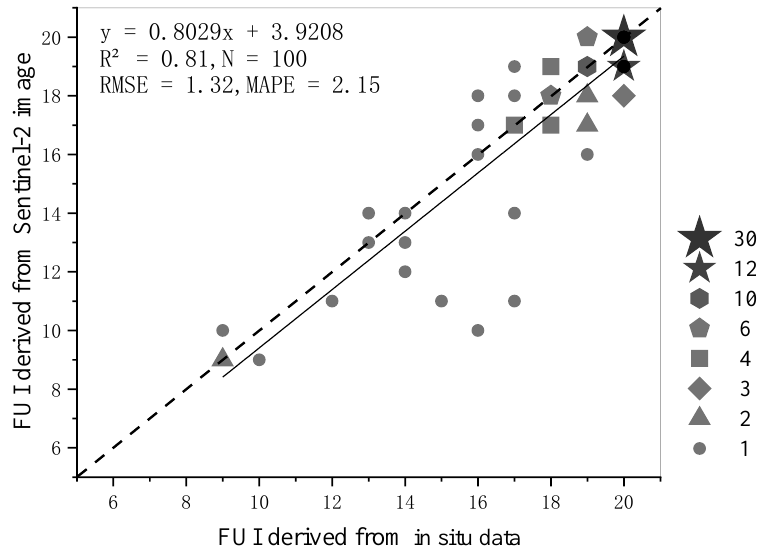
Figure 4. Scatter plots of Sentinel-2-derived FUI and in situ FUI.